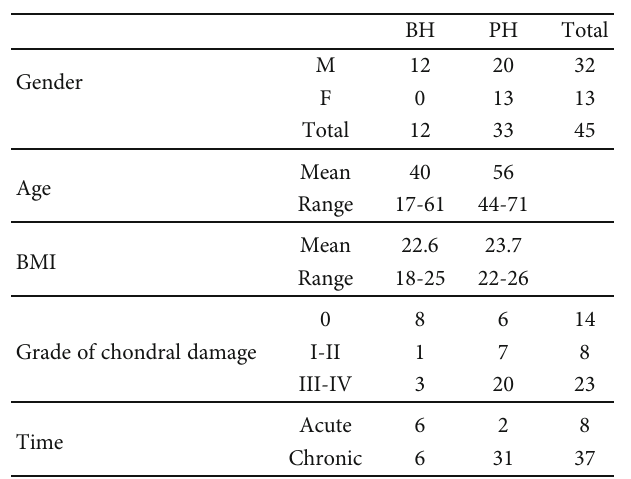
Table 1: Characteristics of patients with bucket-handle (BH) tear and tear of the posterior horn (PH) of the medial meniscus.